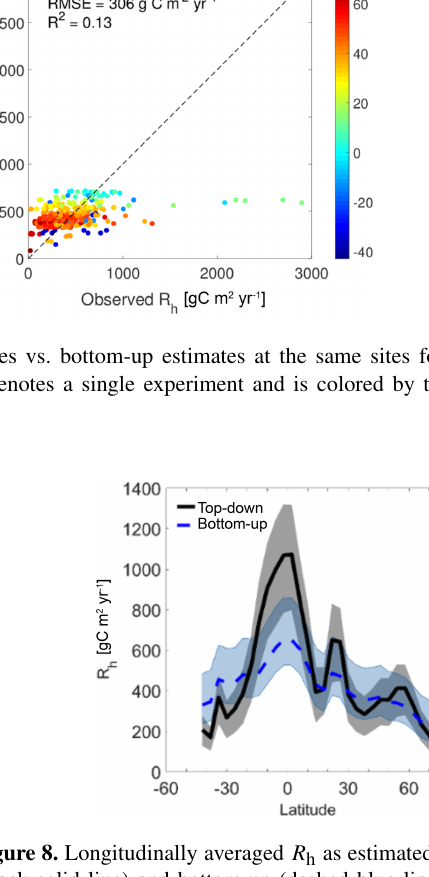
Figure 8. Longitudinally averaged R h as estimated from top-down (black solid line) and bottom-up (dashed blue line) estimates, re- spectively. Shaded areas represent the average 25th–75th uncer- tainty bars at each